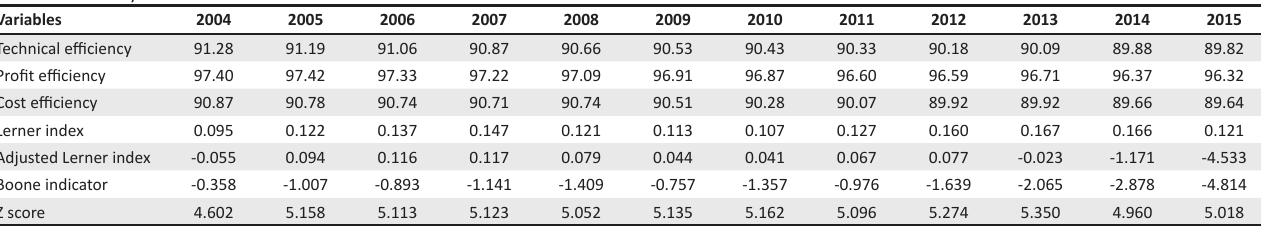
TABLE 3: Summary of statistics for all banks. Variables